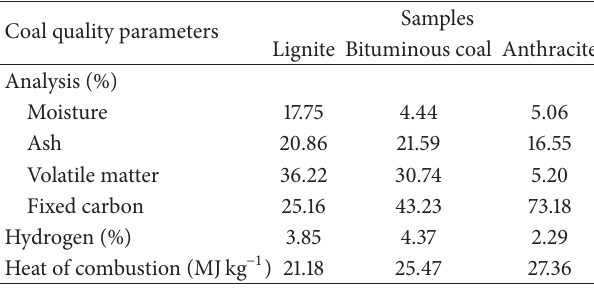
Table 1: Main coal quality indexes of coal